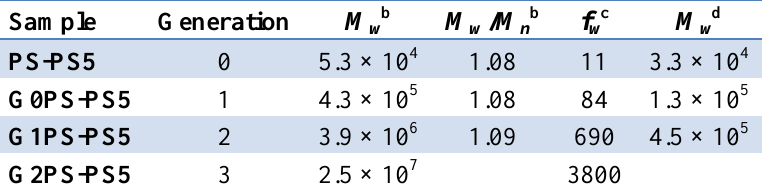
Table 1. Characterization data for a series of arborescent styrene homopolymers synthesized from acetylated polystyrene substrates.